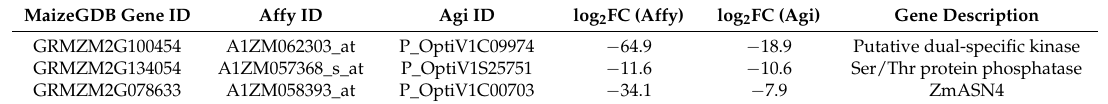
Table 5. Three common genes of ANNs-all transcripts across chips comparison.